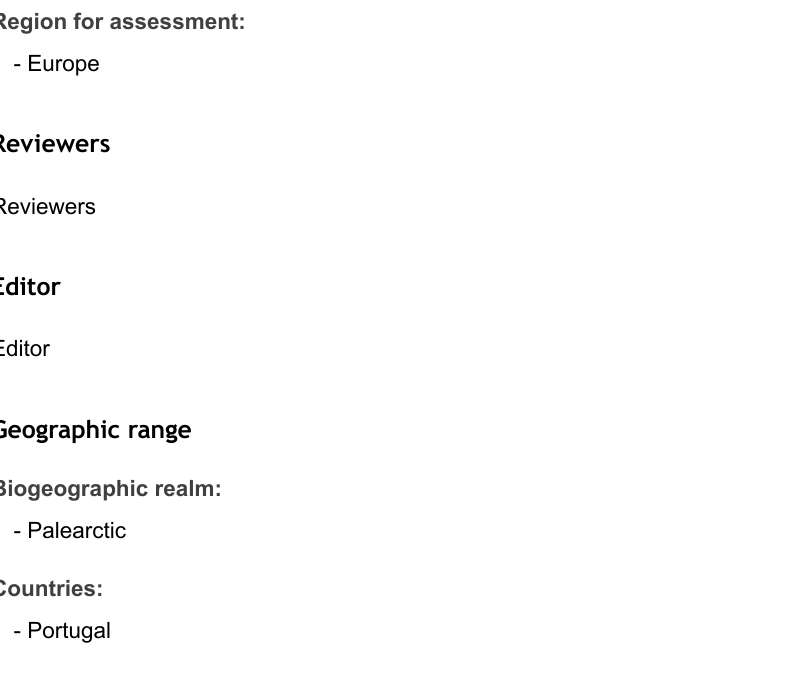
Kingdom Phylum Class Order Family Animalia Arthropoda Malacostraca Isopoda